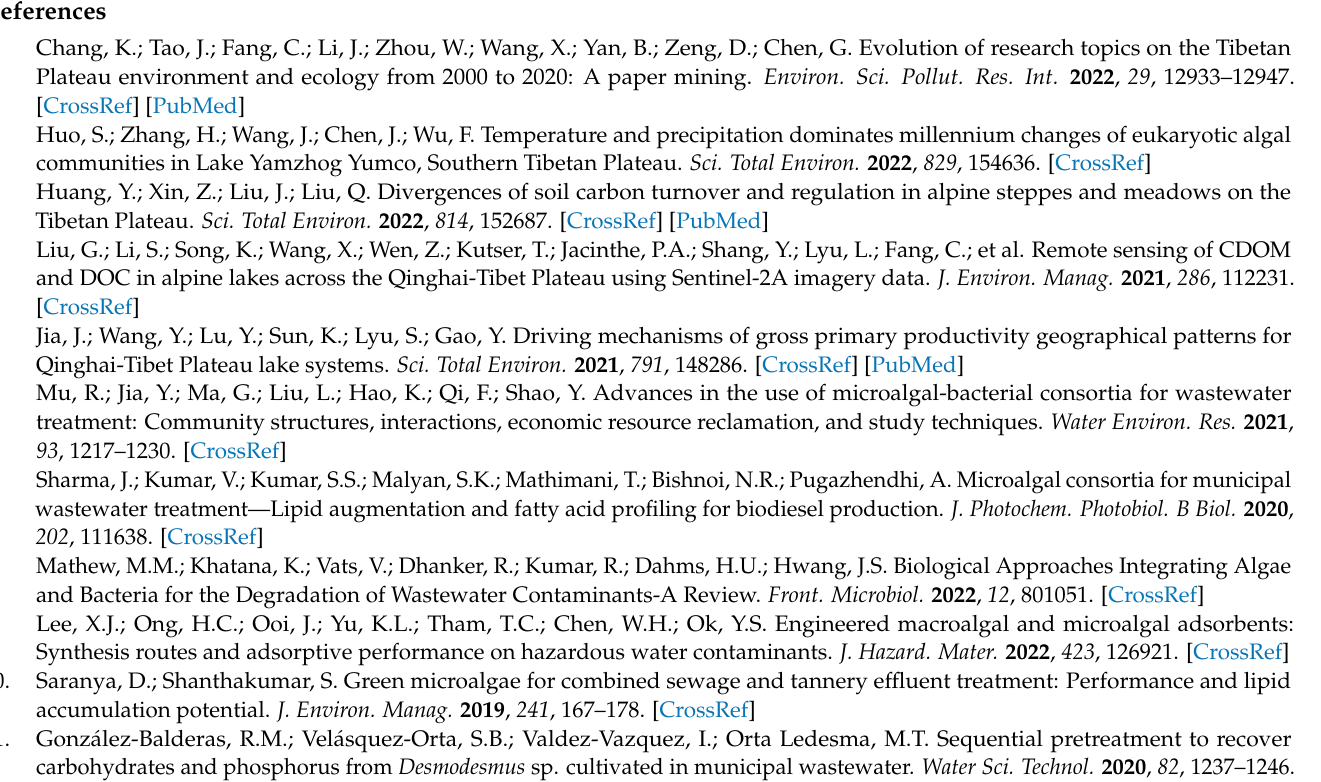
Table S6. Differential metabolites in negative polarity mode in YH_4 vs. YH_3. Table S7. KEGG enrichment in positive polarity mode in YH_3 vs. YH_4. Table S8. KEGG enrichment in